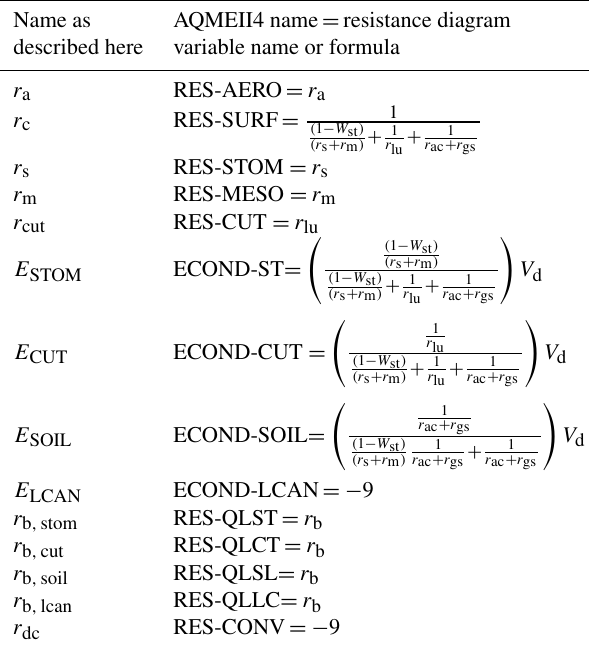
Table B5. AQMEII4-reported gaseous deposition variables corresponding to the GEM-MACH Zhang resistance model of Fig. B5. Name